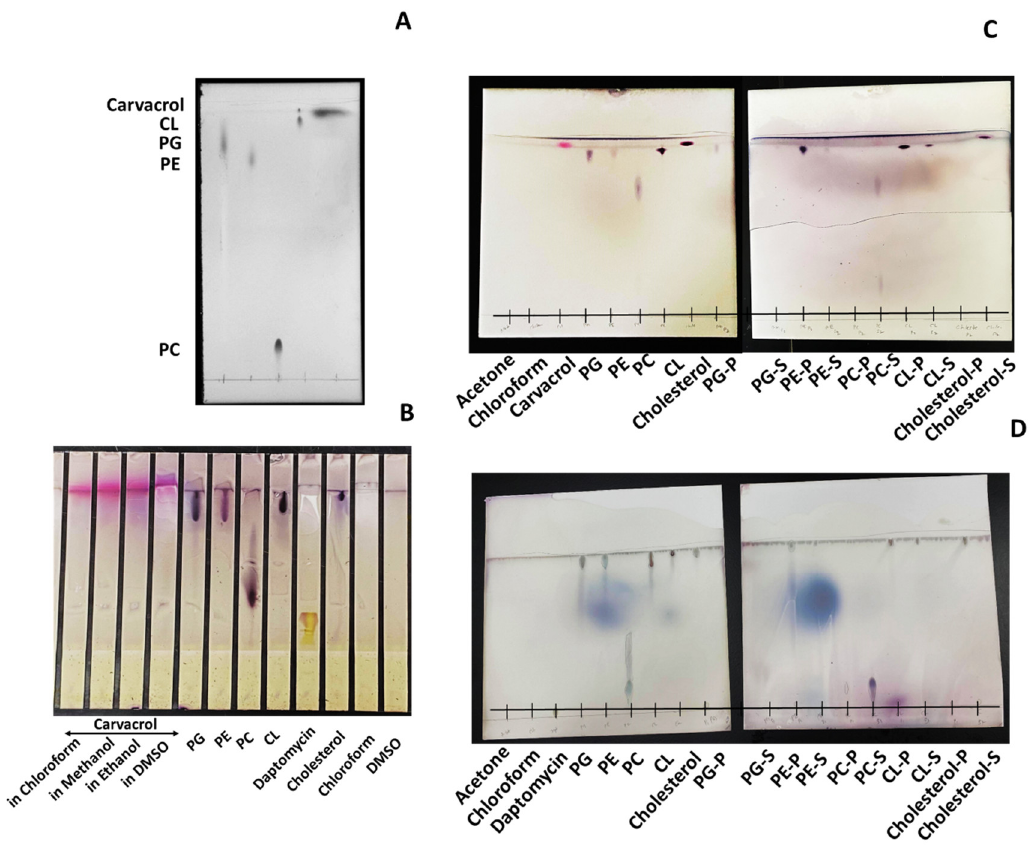
Figure 5. Visualization of thin-layer chromatography (TLC). ( A ) UV visualization of phospholipid standards (25 mg/mL, each) and carvacrol (12.5 mg/mL), ( B ) selection of better solvents and detection method for all samples, ( C ) carvacrol, and ( D ) daptomycin interaction with phospholipids. Phospholipids: carvacrol/daptomycin (2:1 v / v , in chloroform) were incubated for 1 h, and the phospholipids were precipitated using cold acetone. Precipitant (P) and supernatant (S) were collected by high-speed centrifugation (21,000× g ), drying, and reconstituted with chloroform. The TLC plates were developed with the solvent system of chloroform-methanol-water (65:25:10 v/v/v ). TLC plates were then stained with alcoholic vanillin–sulphuric acid solution, heated in an oven, and visualized under UV. The colors of the spots were compared and identified in photographs of TLC plates, and their mobilities (Rf) were compared with those of phospholipids. P.G.: Phosphatidylglycerol; P.E.: